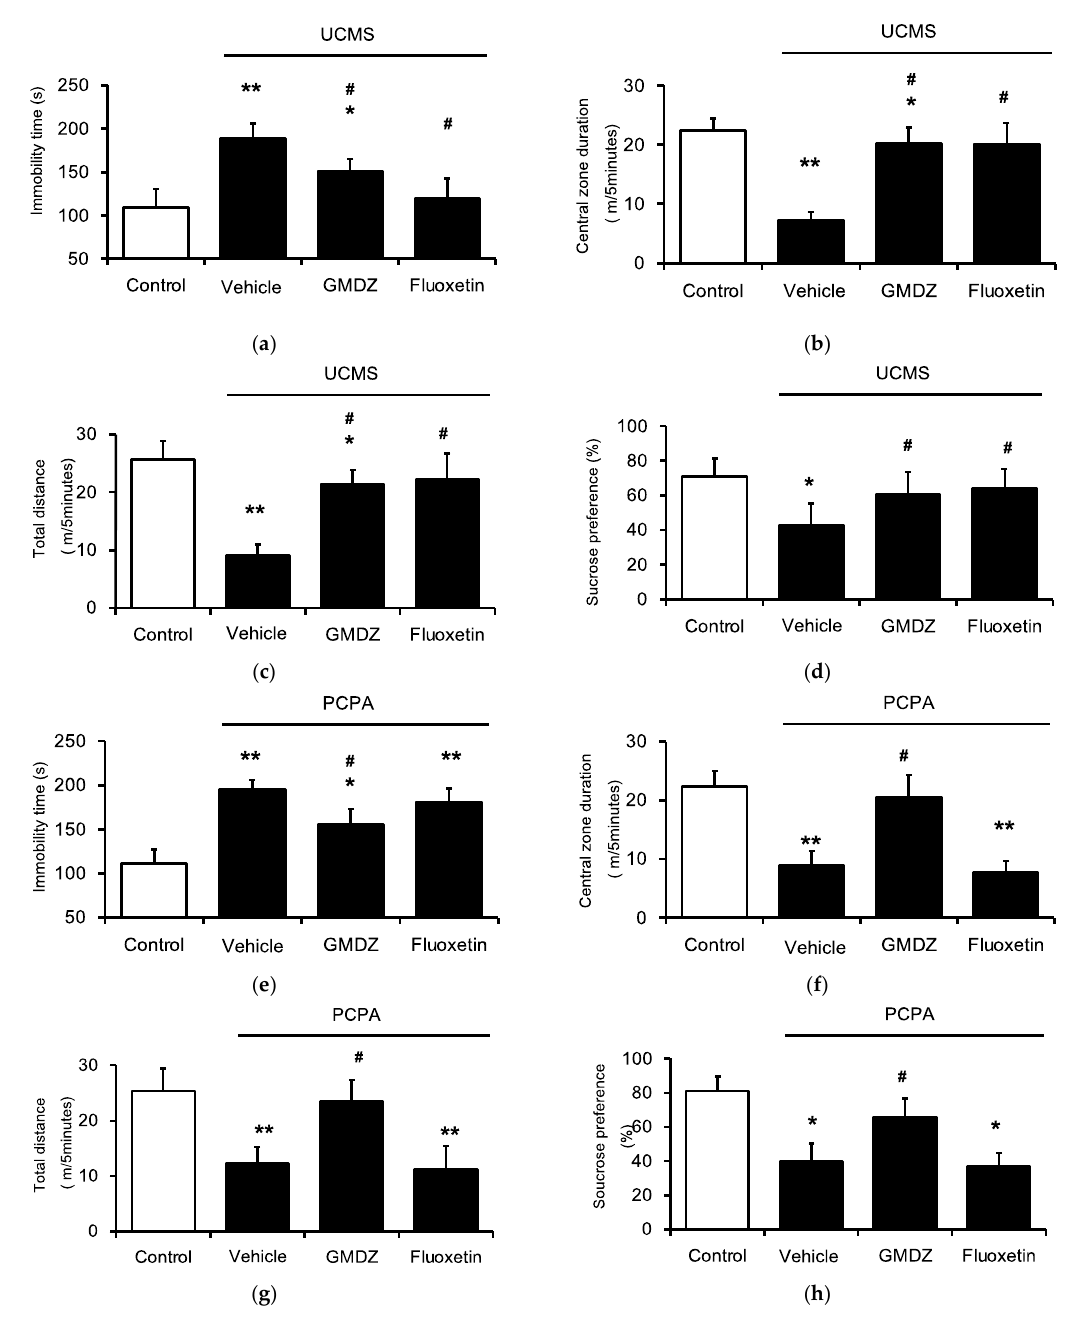
Figure 1. GMDZ ameliorated depression-like behaviors in two rat models induced by the UCMS or PCPA injection. ( a ) The changes of immobility time in FST in UCMS model; ( b ) the changes of time in central in OFT in UCMS model; ( c ) the changes of traveling distance in OFT in UCMS model; ( d ) the changes of sucrose solution consumption (%) in SPT in UCMS model; ( e ) the changes of immo- bility time in FST in PCPA treated groups; ( f ) the changes of time in central in OFT in PCPA treated groups; ( g ) the changes of traveling distance in OFT in PCPA treated groups; ( h ) the changes of sucrose solution consumption (%) in SPT in PCPA treated groups. Responses to fluoxetine used as the positive control. Data are expressed as mean ± SE ( n = 8). * p < 0.05, ** p < 0.01 compared with the normal control group; # p < 0.05 compared with vehicle-treated group. The SPT is a procedure which is used to measure the hedonic value of sucrose, typi- cally reduced in animals with depression-like disorders. Both the UCMS and PCPA